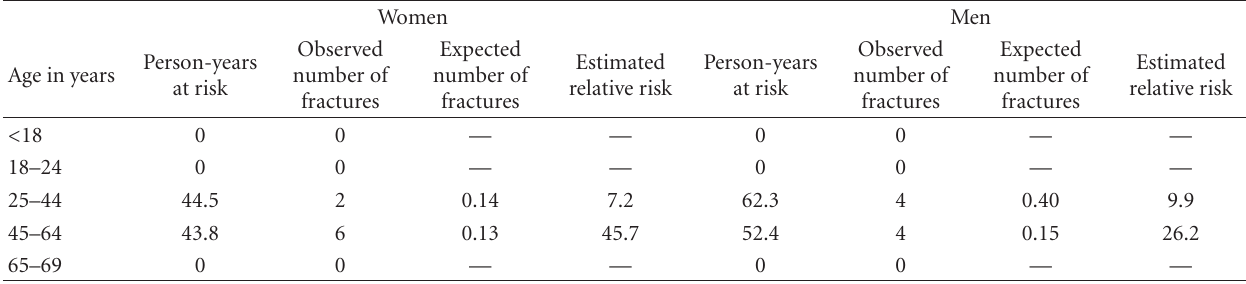
Table 5: Age- and gender-specific fracture incidence rates in kidney/pancreas transplant recipients.